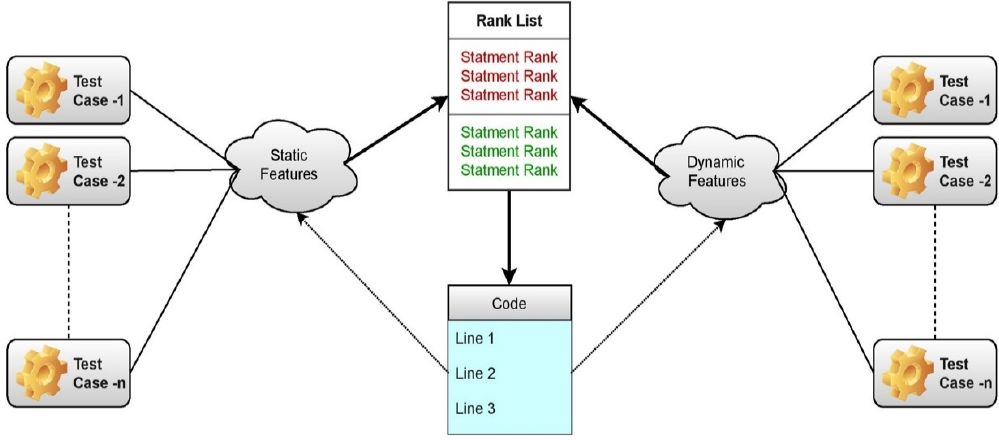
Figure 1. Represents the static and dynamic features in statement rank generation.